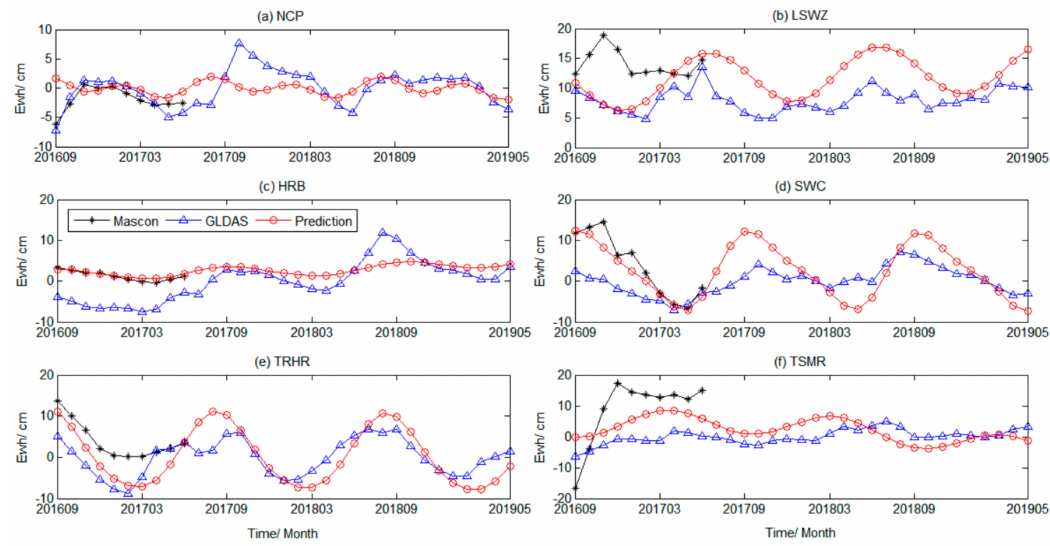
Figure 8. Comparison of GRACE TWS predicted by SSA with Mascon and GLDAS results. The red curve represents the prediction time series, the black curve represents the Mascon time series, and the blue curve represents the GLDAS time